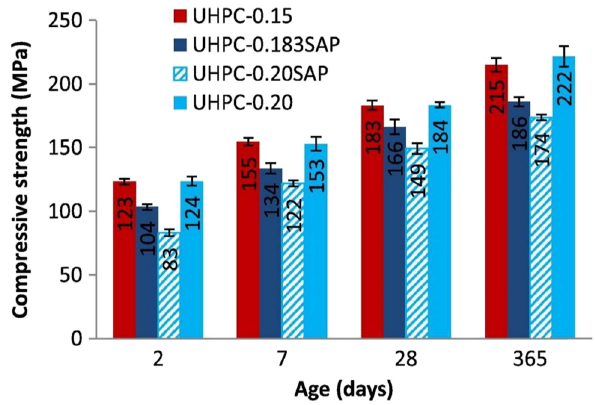
Figure 5: Compressive strength of UHPC with SAPs [ 16 ] .